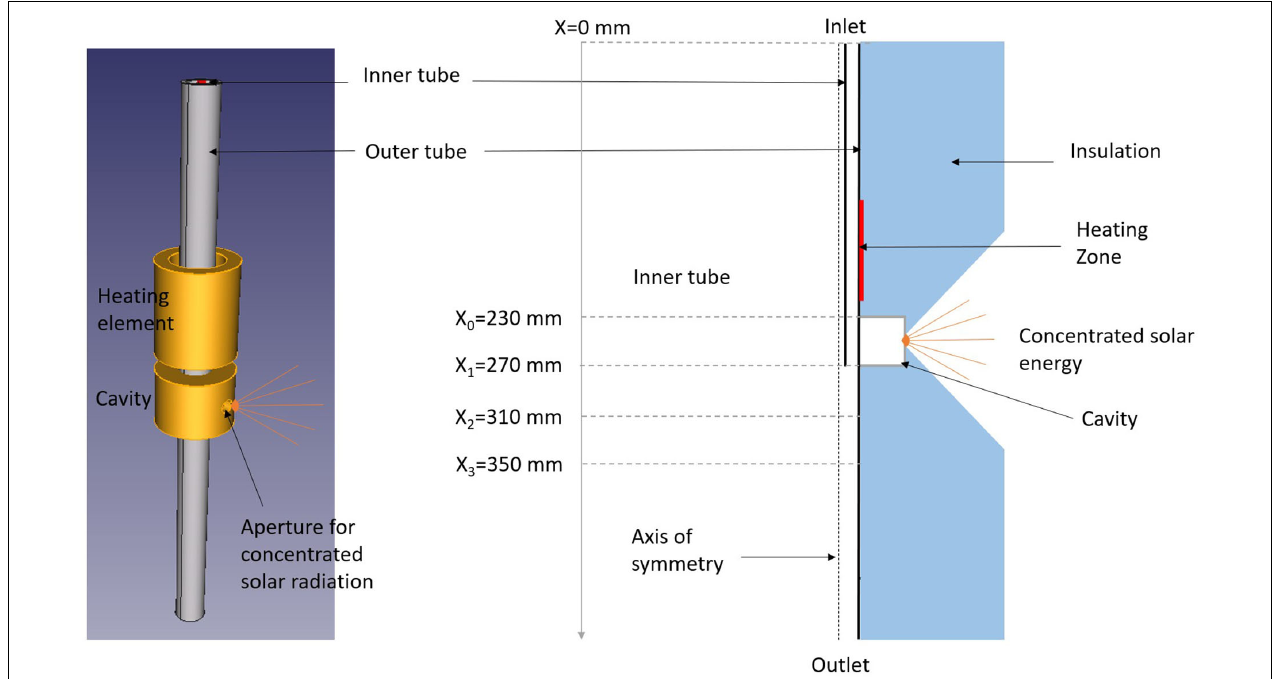
FIGURE 1 | 3D schematic view of the reactor without insulation and geometry used for axisymmetric modeling.